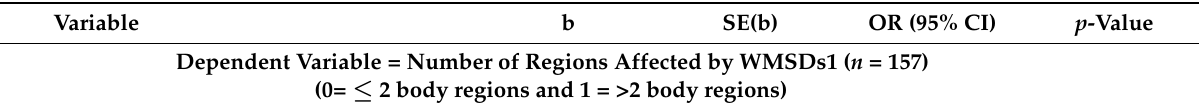
Table 7. A binary logistic regression model was used to identify predictors of >2 body regions affected by WMSDs by sociodemographic and work environment risk